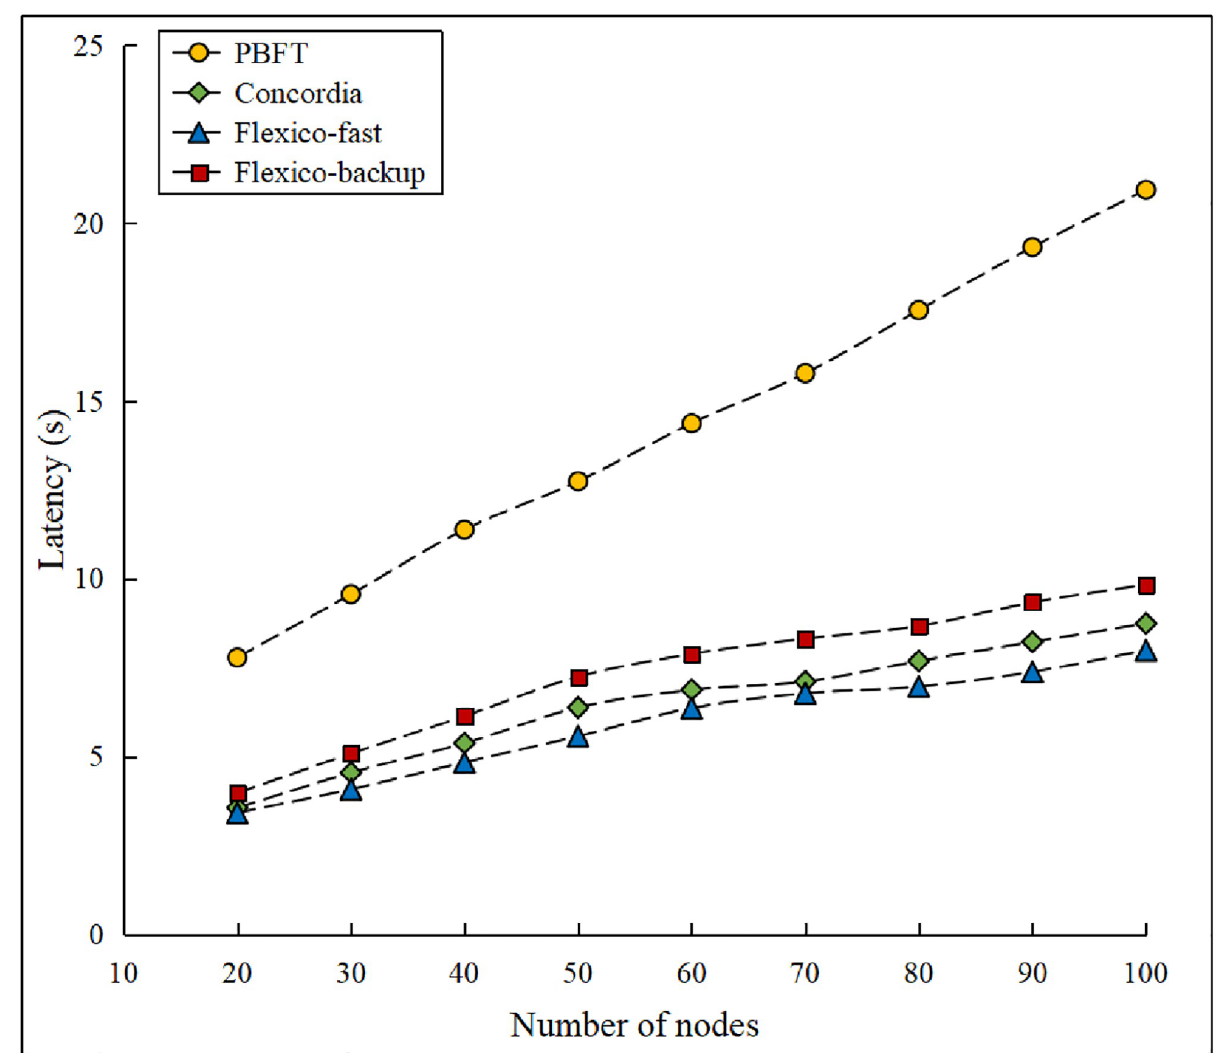
Fig 8. Consensus performance comparison.